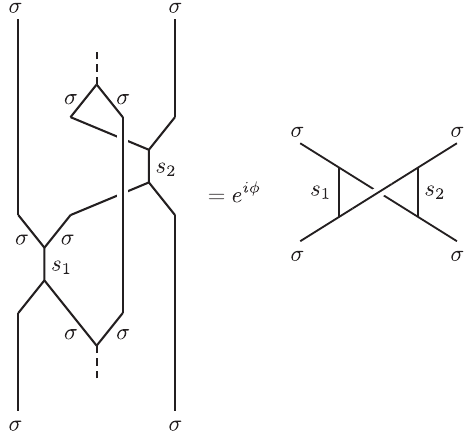
FIG. 6. The measurement-only protocol for braiding. The resulting operation depends on the fusion channels s 1 and s 2 of the intermediate measurements (which can take the values i or ψ ). If s 1 ¼ s 2 , the result is a counterclockwise braid; otherwise it is the inverse